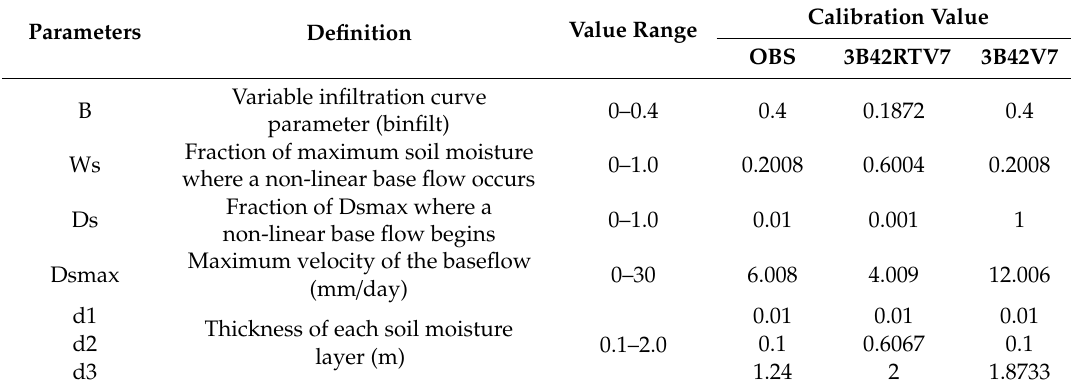
Table 2. The variable infiltration capacity (VIC) model calibrated parameters and calibrated values in the upper Yangtze River